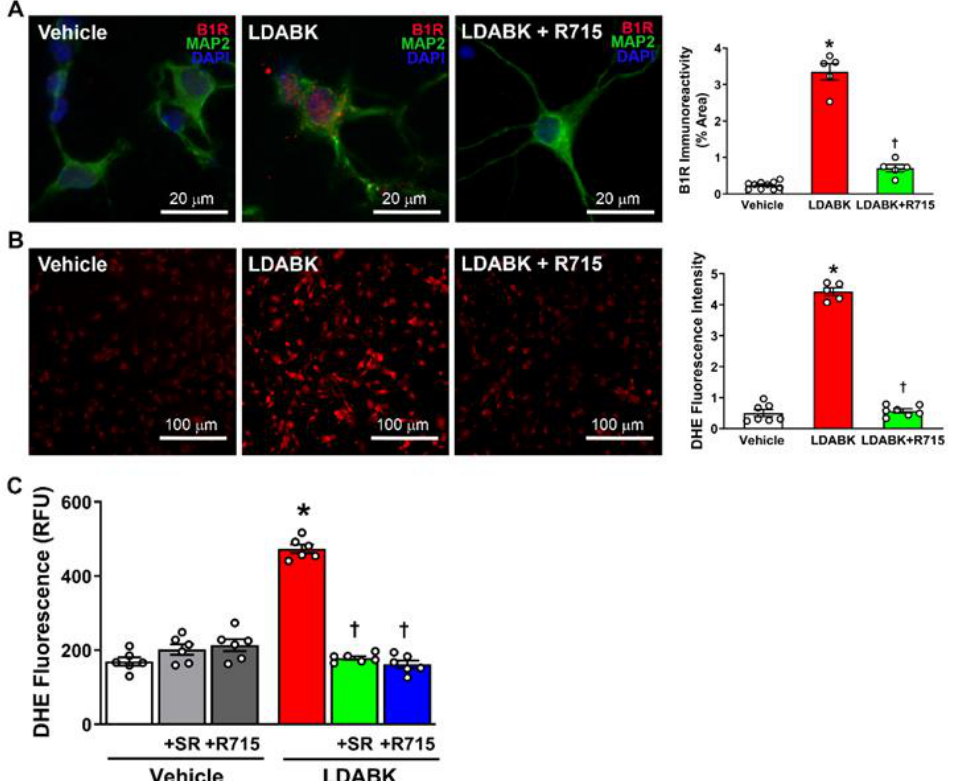
Figure 1. LDABK treatment on primary hypothalamic neurons. ( A ) Immunofluorescence staining and quantification for B1R expression (n = 5–10/group). ( B ) Superoxide generation using dihydroethidium (DHE) staining (n = 5–10/group). ( C ) ROS production measured by microplate DHE